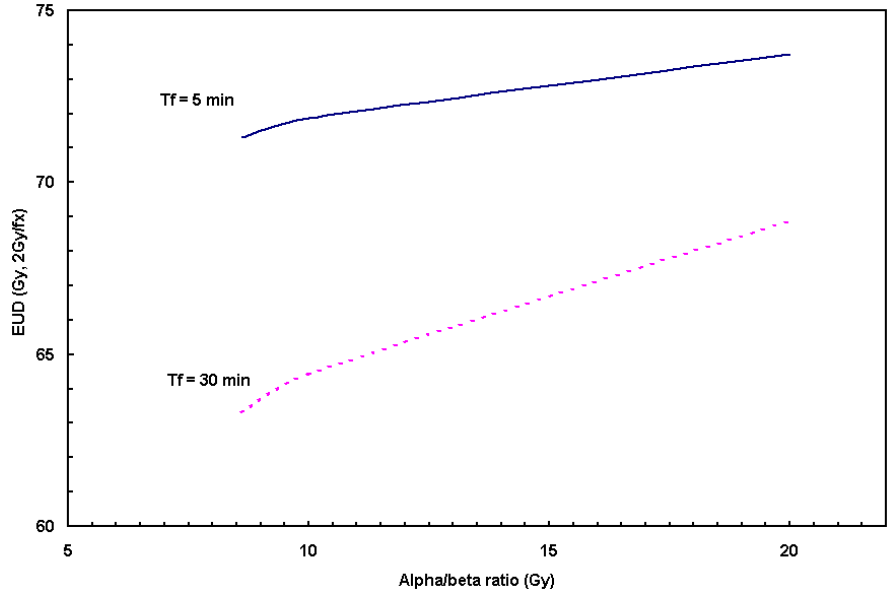
Figure 5. Influence of α / β ratio on EUD for H&N tumor. The result from this analysis α / β = 8.3 Gy was used. The standard fraction scheme was considered in the calculation: 70 Gy in 2